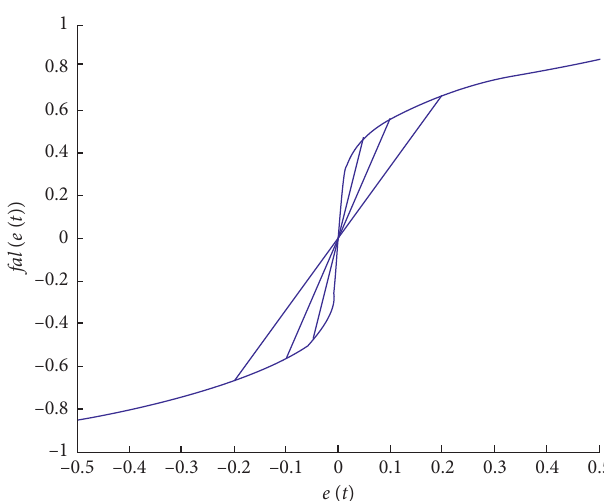
Figure 1: Characteristic curves of the nonlinear function fal ( e ( t ))